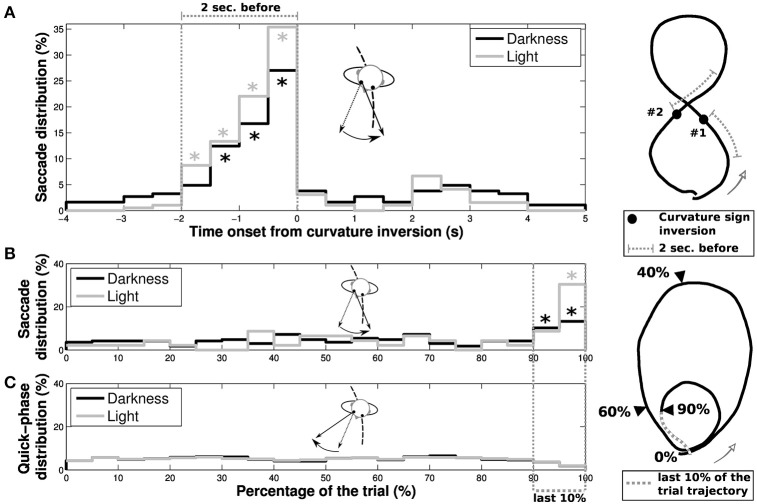
Characteristics of reverse-saccades occurrence. The reverse-saccade occurrence depends on different parameters for (A) elongated eight and (B) limaçon shapes. (A) Distributions of reverse-saccades as a function of the time onset from one of the two curvature sign inversion present in the extended height shape (black and gray for darkness and light conditions, respectively). A large proportion of reverse-saccades are elicited in a period of 2 s before the curvature sign inversion. Stars (*) indicate the bins with a significant difference (i.e., with a value higher than the statistical error N). (B) Distribution of reverse-saccades occurrence as a function of the evolution of participant's progression on the overall limaçon shape. (C) The quick phases (without reverse-saccades) distribution as a function of the participant progression on the trajectory is also presented, for darkness (black) and light (gray) conditions. On the limaçon, a large proportion of reverse-saccades are elicited in the last 10% of the trajectory (39.13% and 23.49% of the reverse-saccades in light and darkness conditions, respectively). Stars (*) indicate the bins with a significant difference.